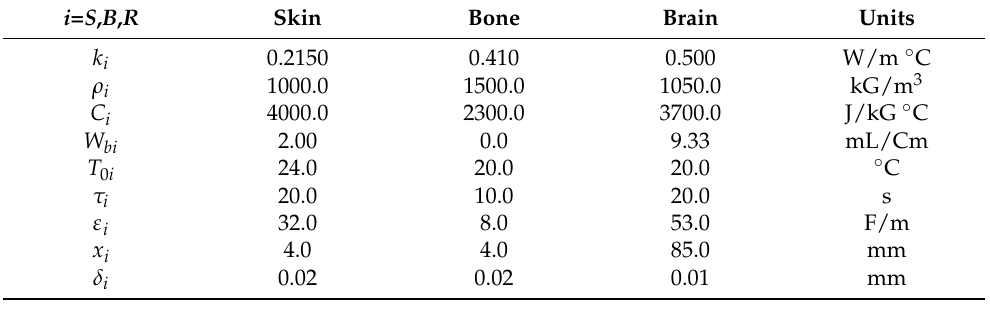
Table 1. Properties of the multi-layer human head